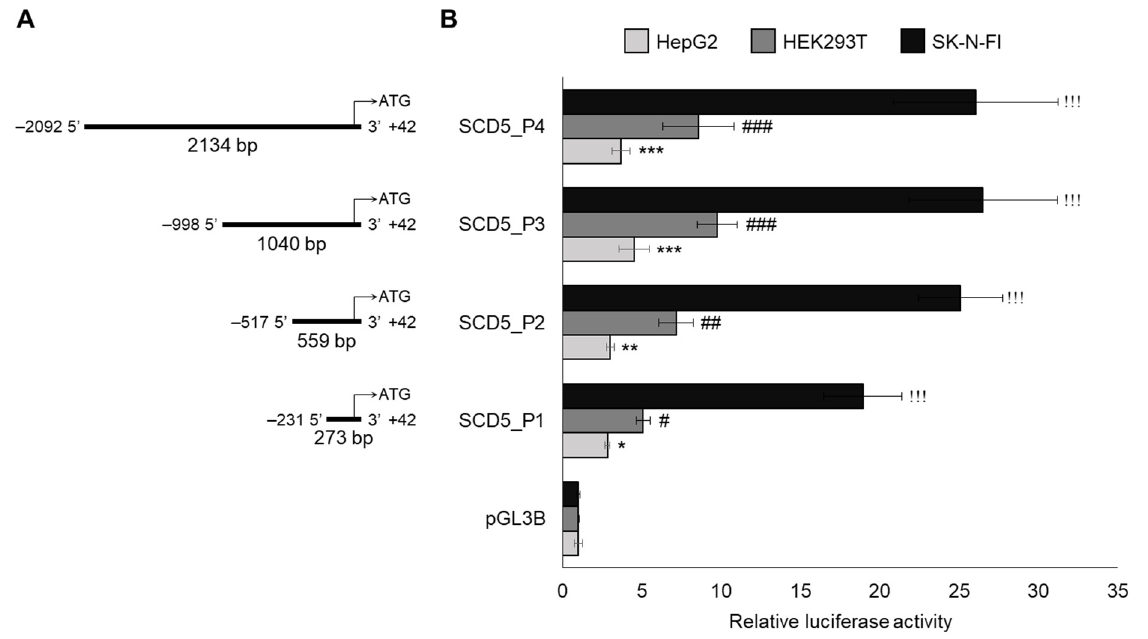
Figure 1. Relative promoter activity of different constructs of human SCD5 gene promoter in three different human cell lines. The length and position of the subcloned SCD5 5 ′ regulatory sequences are numbered from the translation start site (+1) ( A ) and their relative luciferase activity that is measured in HepG2, HEK293T, and SK-N-FI cell lines is presented. ( B ) pCMV- β -gal vector served as transfection control. Luciferase and β -galactosidase enzyme activities were measured as indicated in Section 2, and their relative ratios are shown as bar graphs. The diagram depicts the results of three independent measurements that are normalized to pGL3B “empty” promoterless vector. Data are shown as mean values ± S.D. Statistical analysis was performed by using the Tukey–Kramer Multiple Comparisons Test. * or #: p < 0.05; ** or ##: p < 0.01; ***, !!!, ###: p < 0.001.